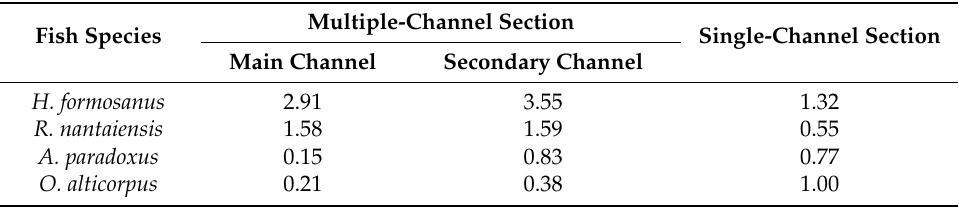
Table 1. The density (individuals/m 2 ) of each fish species in the two sections.